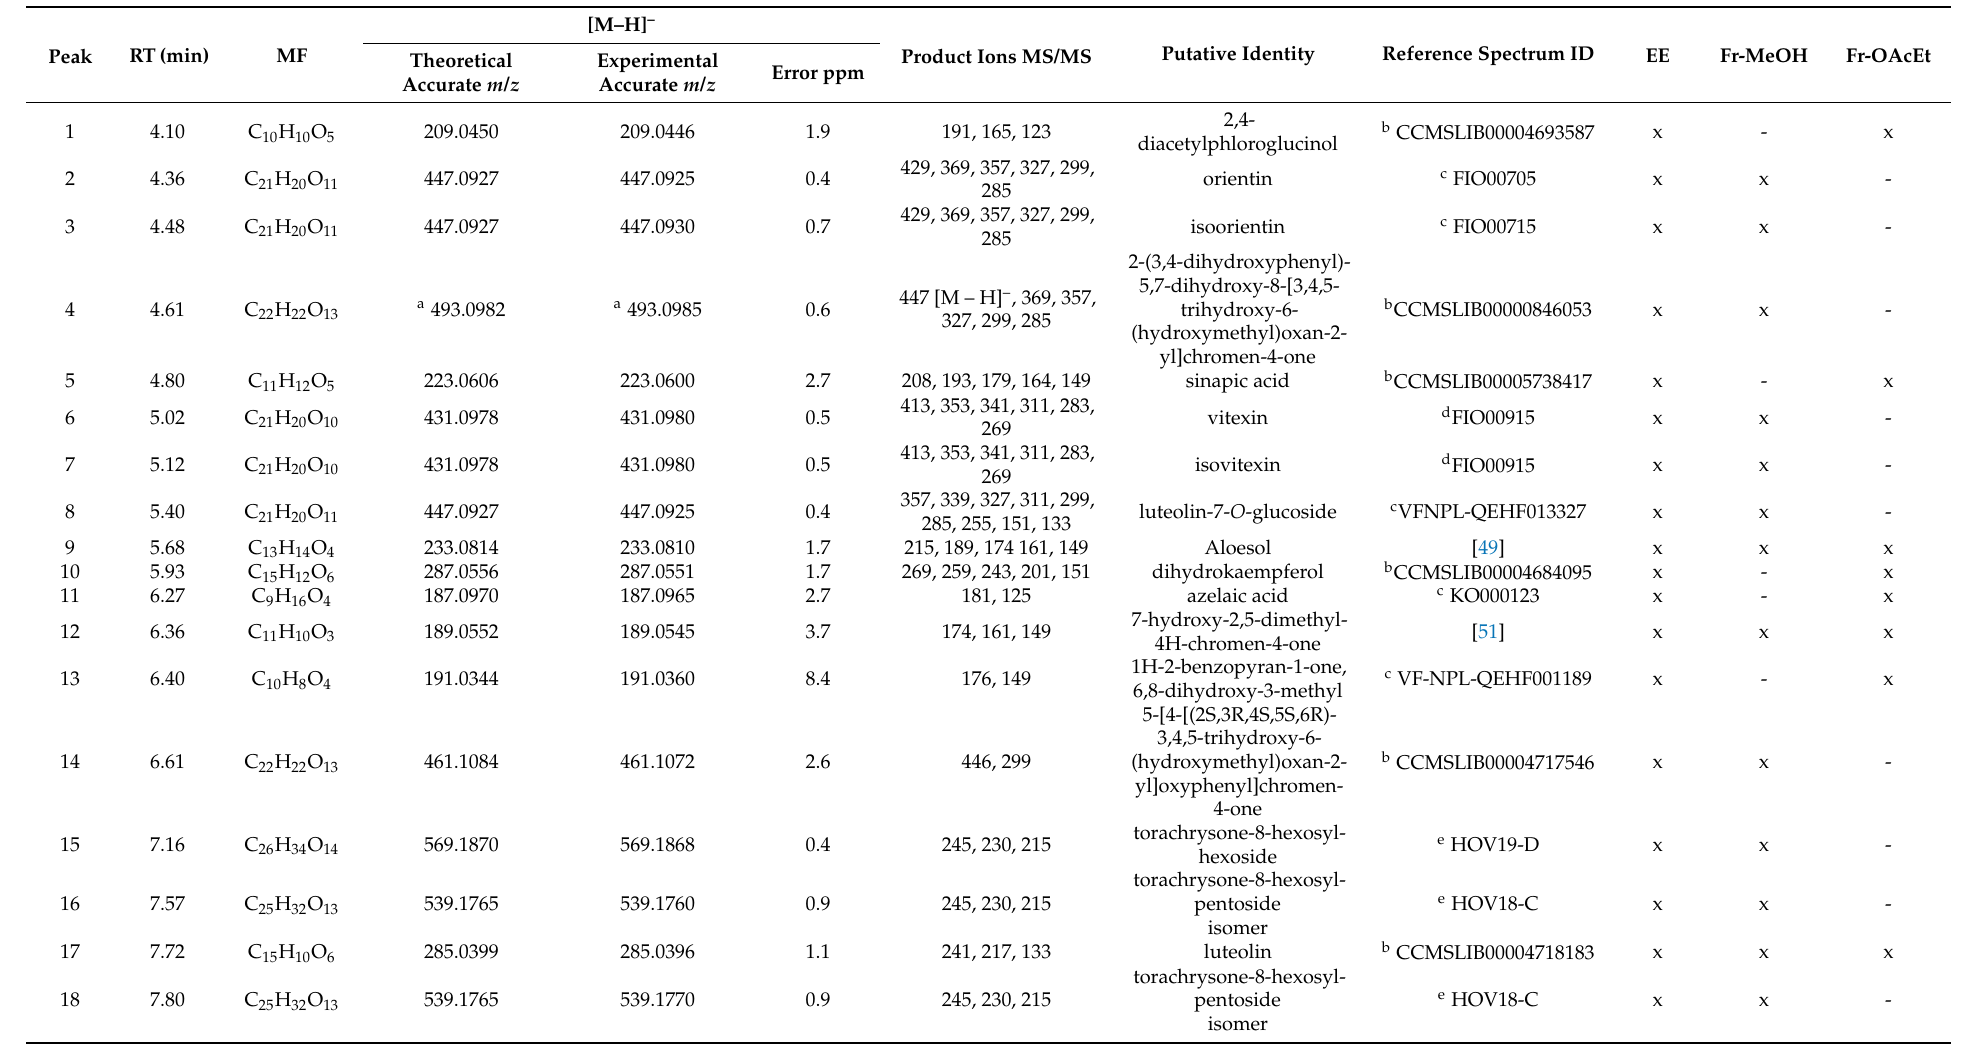
Table 2. Putative identified chemical constituents of Chamaecrista diphylla extract and